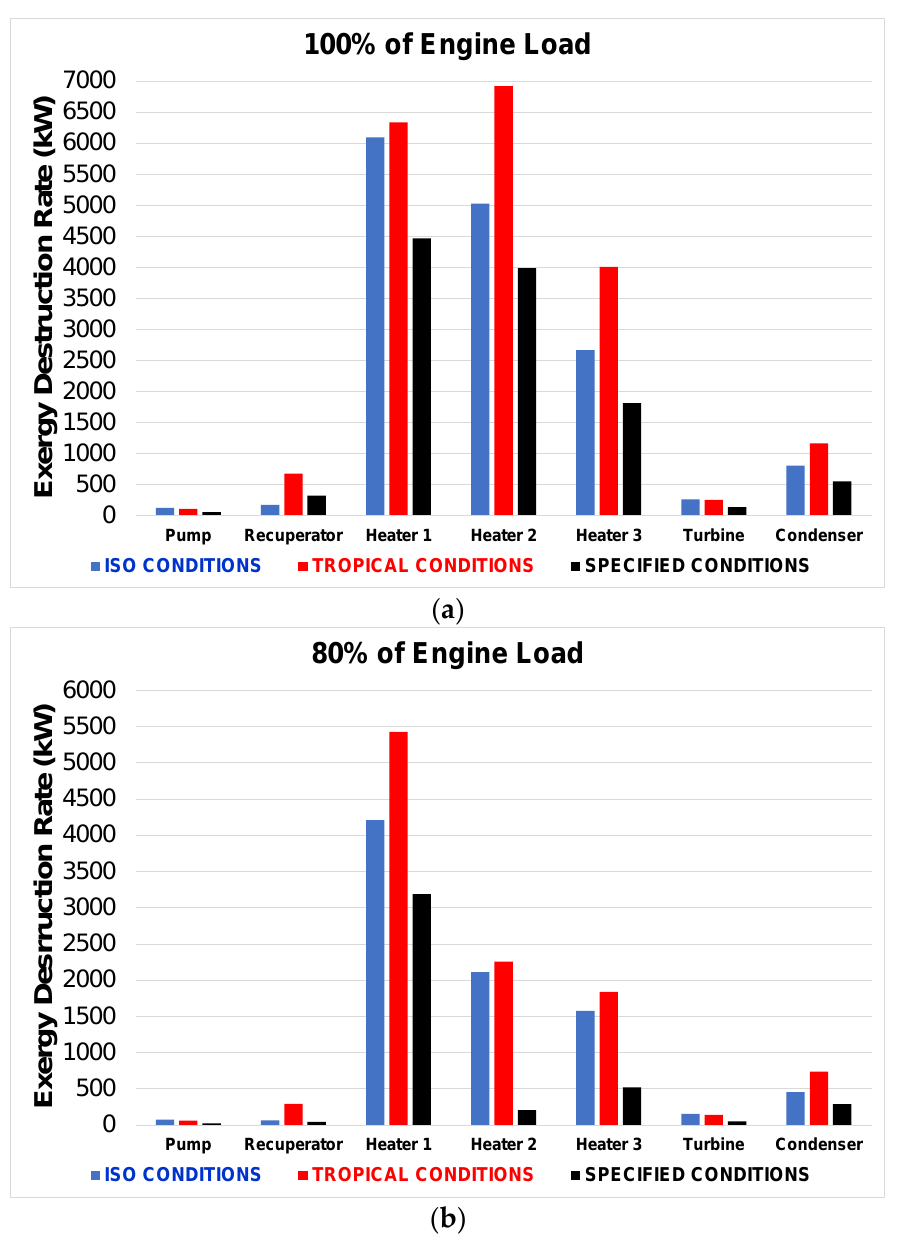
Figure 12. Variation of ( a ) the exergy destruction rate of each component at full engine load and ( b ) the exergy destruction rate of each component at 80% of full load for ISO, tropical, and specified conditions.